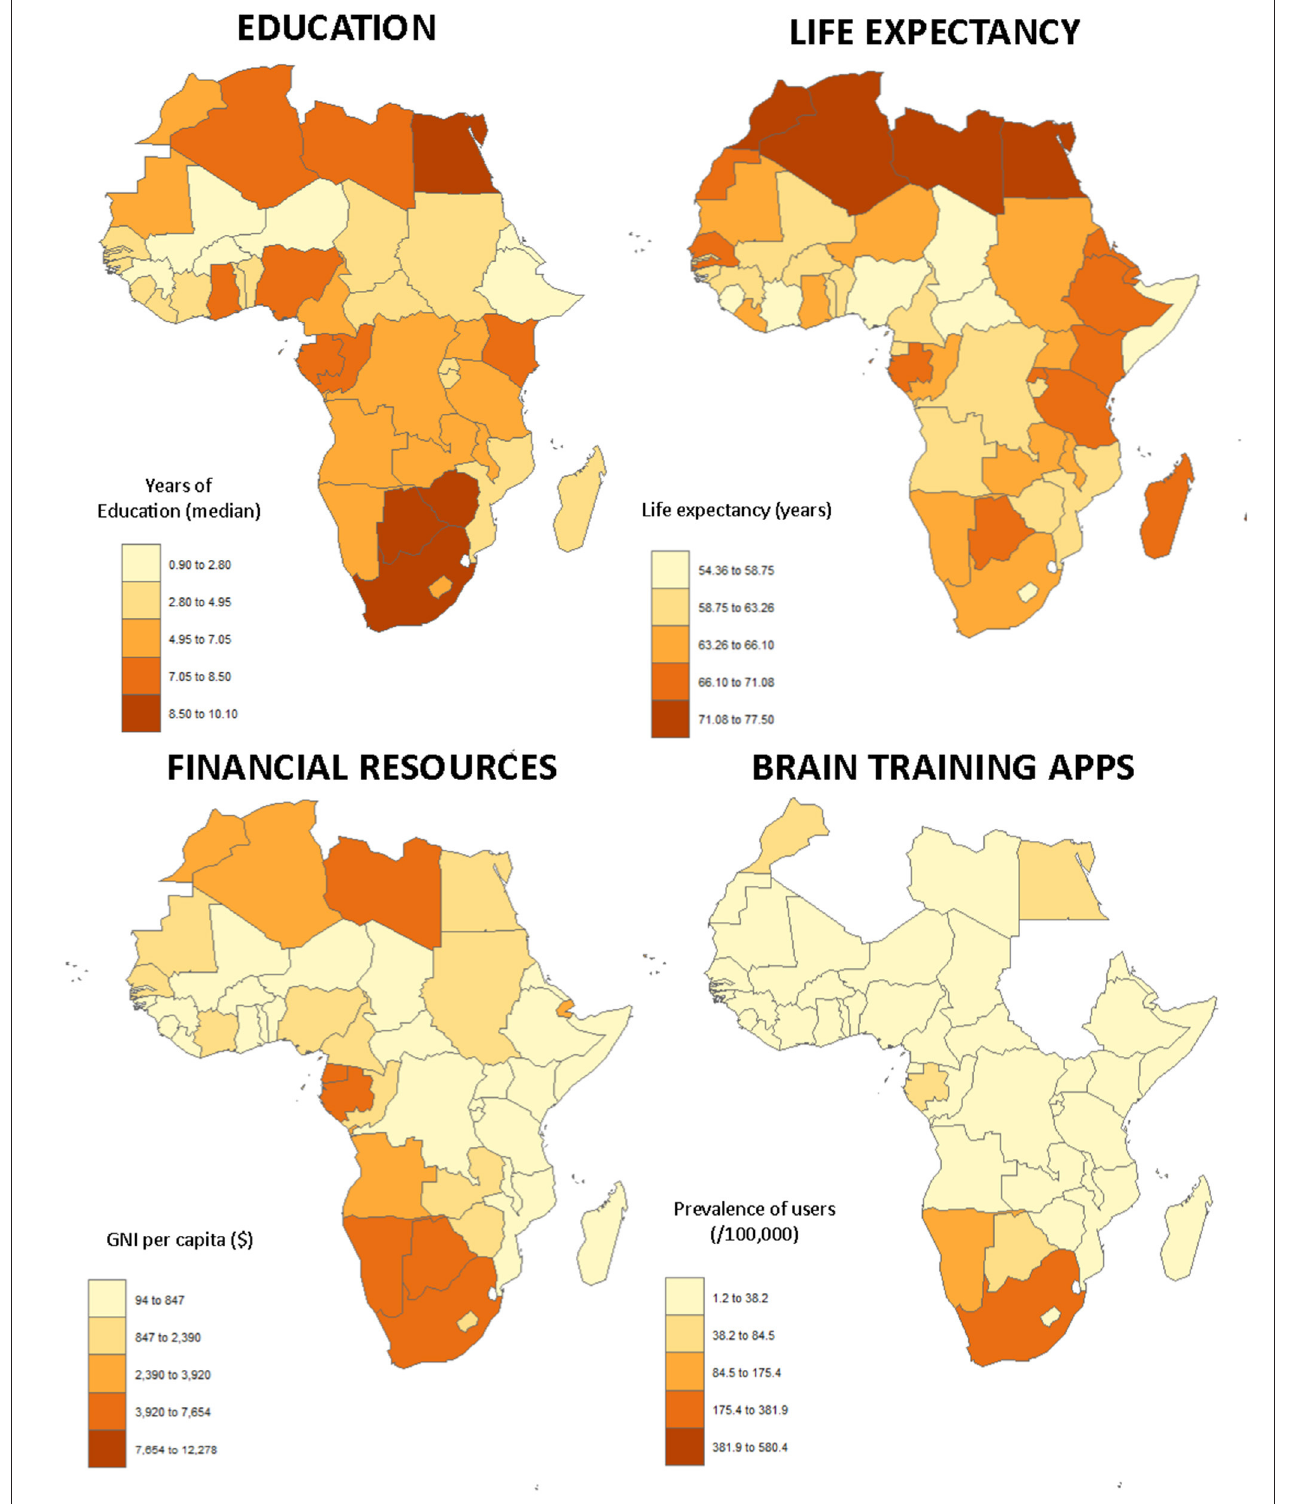
FIGURE 1 | The top figures present two of the most important risk factors of dementia aggregated at the country level: low educational level (left) and life expectancy (right). The figures at the bottom relate to the use of technology, with GNI per capita on the left and the prevalence of users of the application per country on the right.